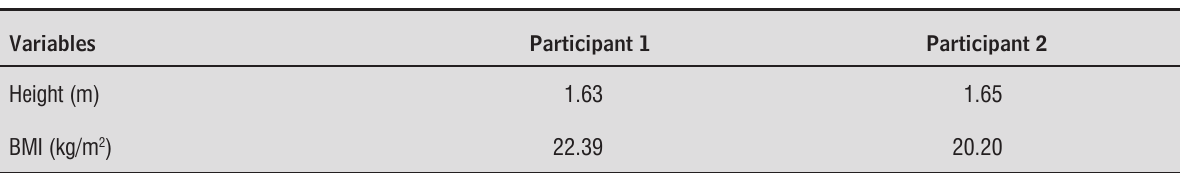
Table 1 - Spirometric and anthropometric data for the two participants